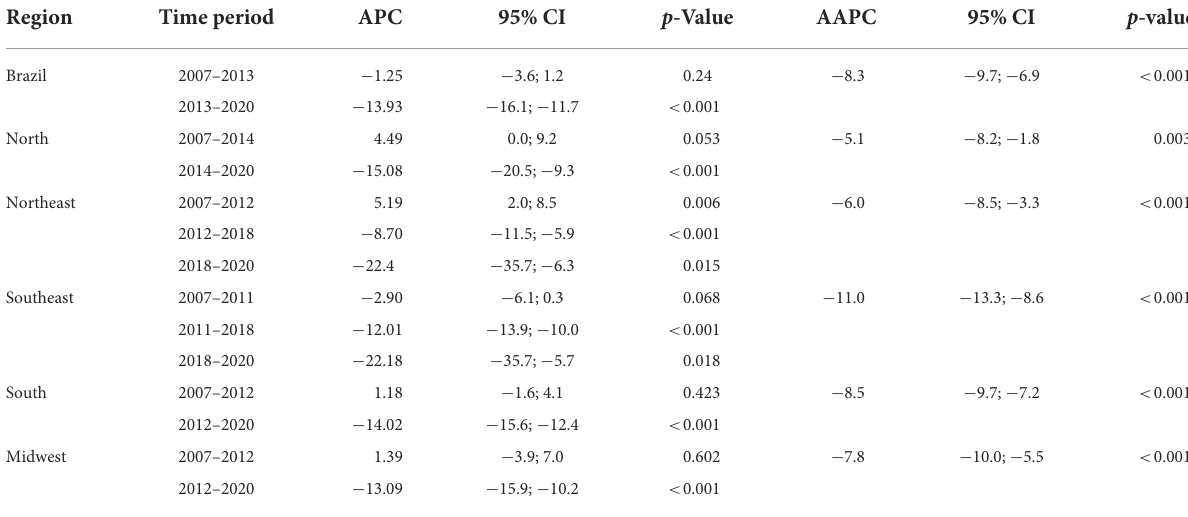
TABLE 1 Temporal trend analysis of annual aged-adjusted HIV/AIDS population-level incidence rates in Brazilian WSM, 2007–2020. Region Time period APC 95% CI p -Value Brazil